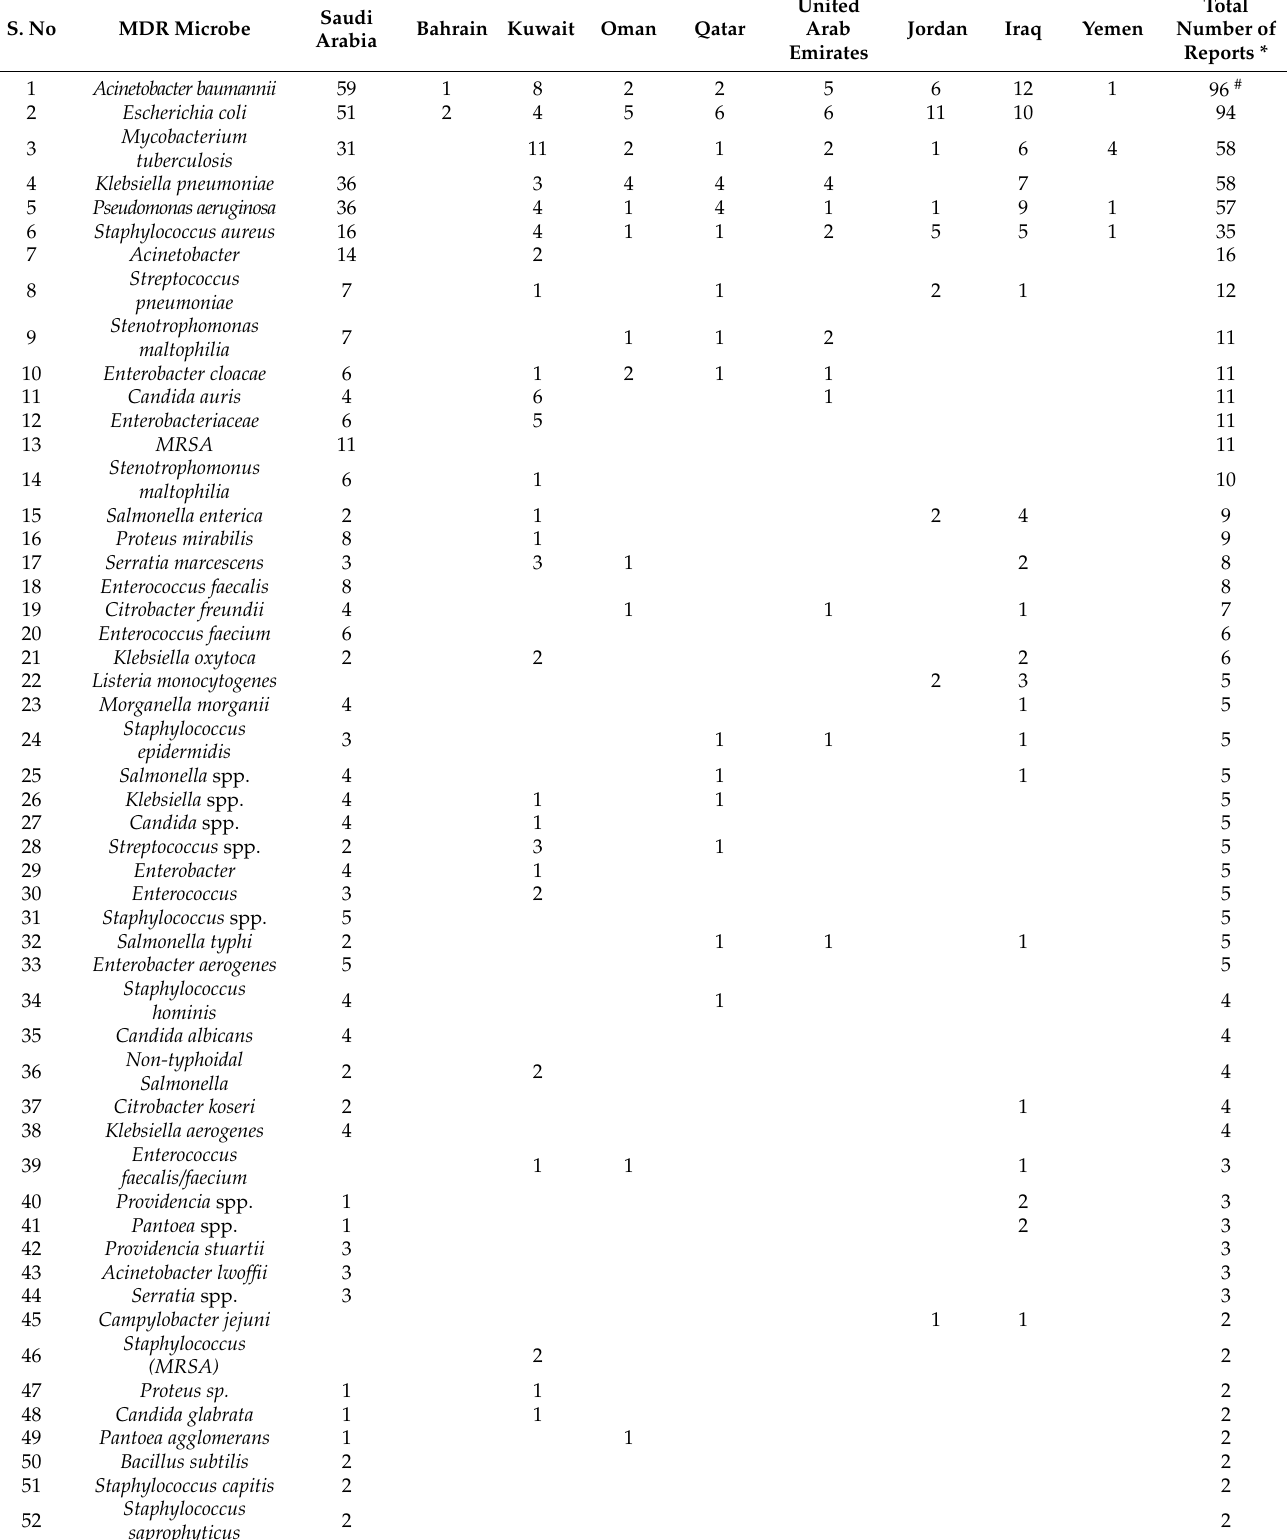
Table 2. Total number of studies that reported the MDR microbe in countries of the Arabian